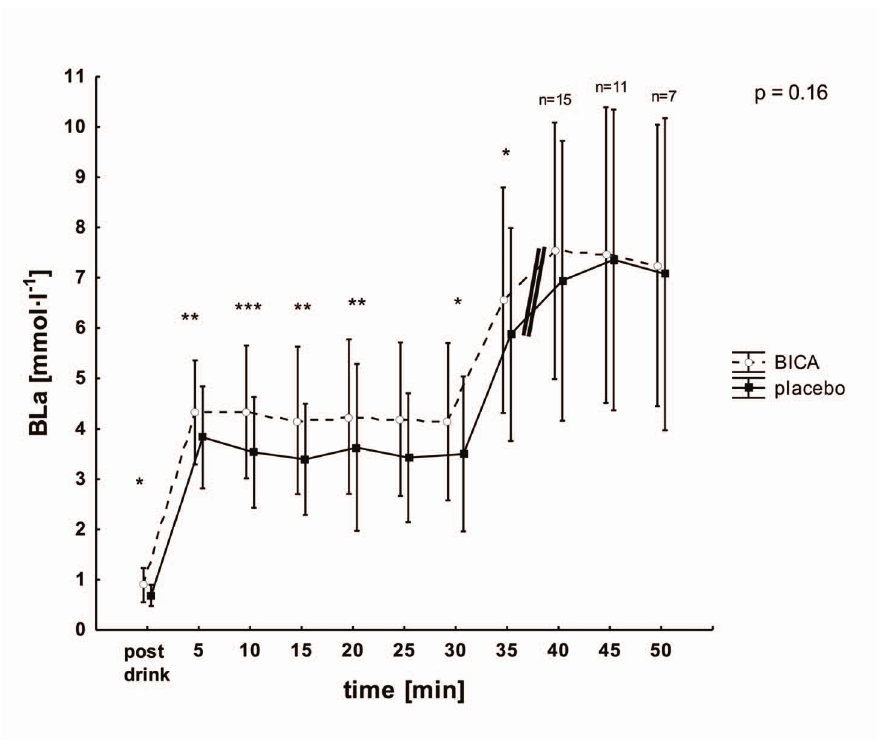
Fig. 4. Blood lactate (BLa) concentrations after ingestion (post drink) and during constant load tests (mean ¡ SD) for the BICA (open circles) and placebo (closed squares) trials. Double bar 5 decrease in number of exercising subjects (n , 21). p 5 interaction between condition and time. * significant effect of condition, p , 0.05; ** significant effect of condition, p , 0.01; *** significant effect of condition, p , 0.001.